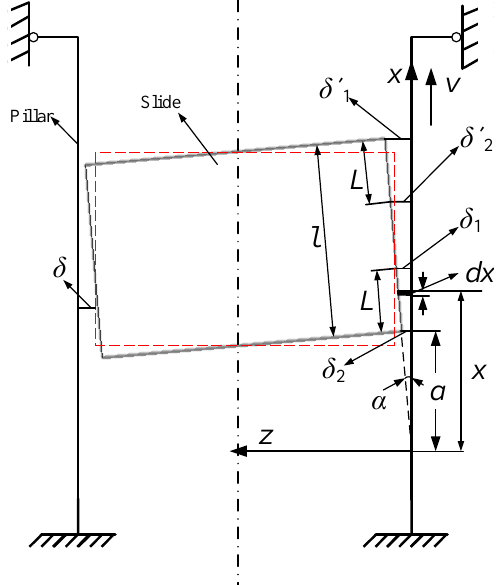
Figure 2. The wedge oil-film clearances in hydraulic press between slide and pillars under eccentric loads.